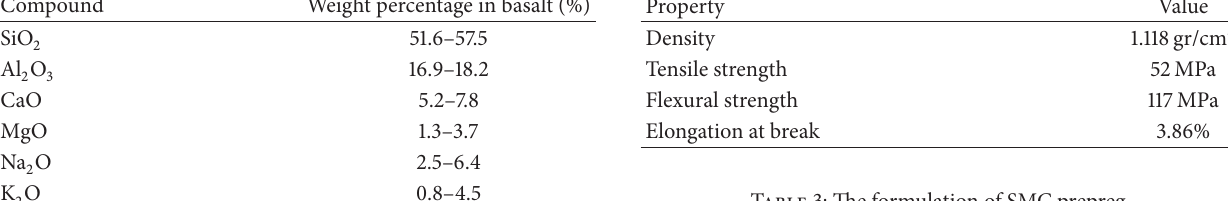
Table 3: The formulation of SMC